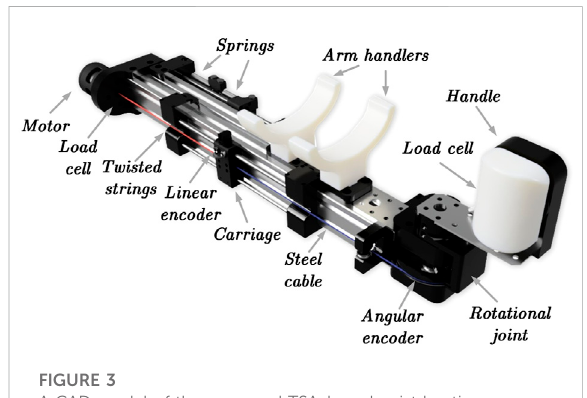
FIGURE 3 A CAD model of the proposed TSA-based wrist haptic interface.